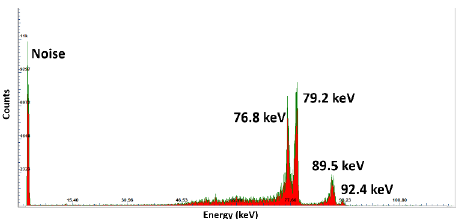
Figure 8. CdTe spectrum showing the 4 astatine peaks are 76.8